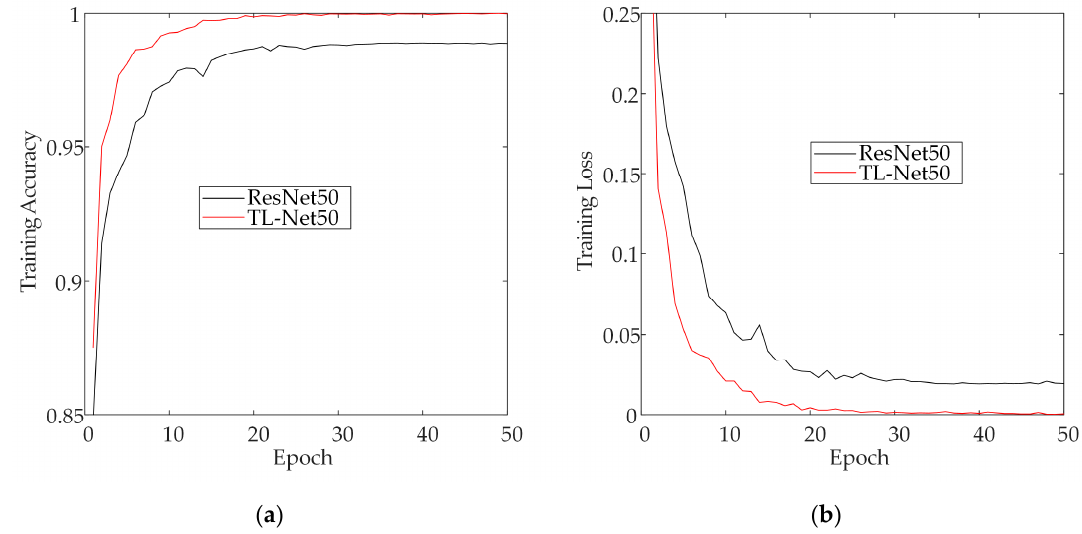
Figure 11. ( a ) The training accuracy curves of ResNet50 and TL-Net50; ( b ) the training loss curves of ResNet50 and TL-Net50.